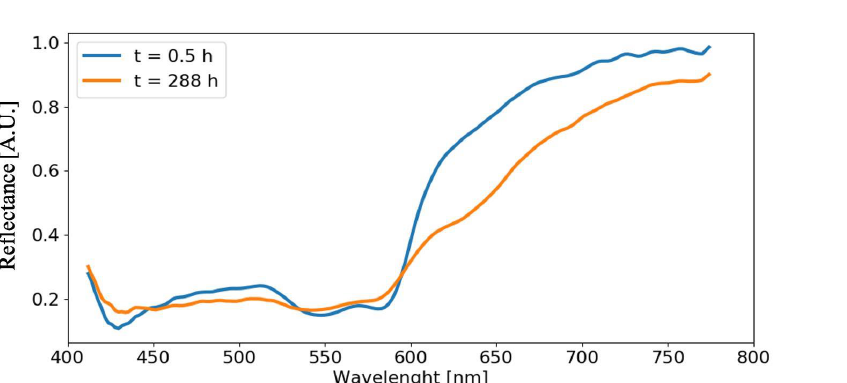
Figure 8. Reflectance spectra comparison between fresh and aged blood on reference substrate C 5 at time t = 0.5 h and t = 288